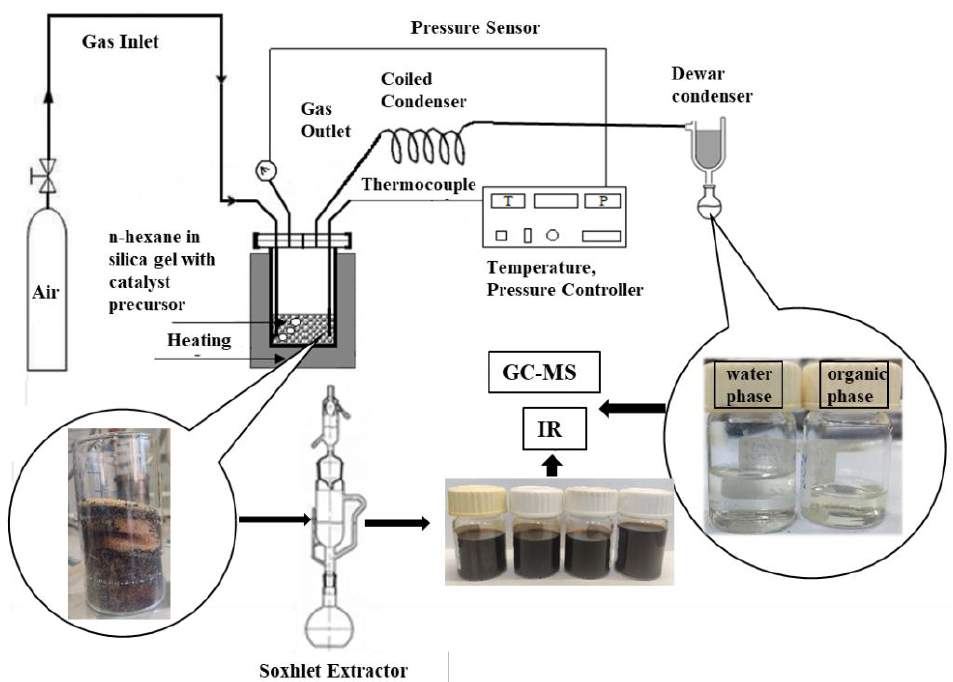
Figure 2. Schematic illustration of experimental set-up.